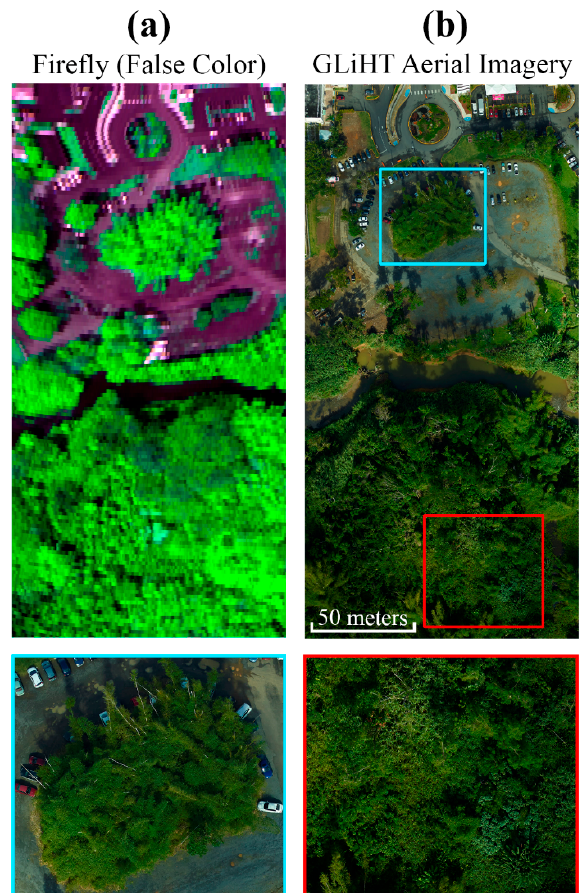
Figure 23. ( a ) False color RGB FIREFLY image (red: 670.2 nm, green: 780.2 nm, blue: 700.9 nm) from an in-flight acquisition in Puerto Rico, USA (greens: vegetated targets; purples / pinks: non-vegetated targets); ( b ) high resolution aerial photograph from G-LiHT RGB camera, with zoom of mixed cover (light blue box), and vegetation (red box)